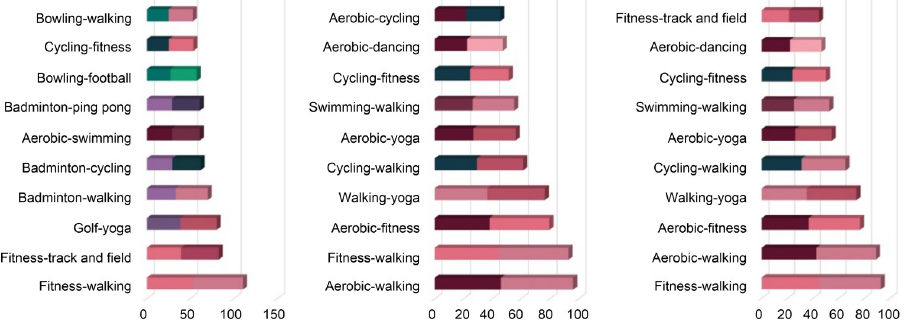
Fig 6. Survey (actual physical activity)—Top 10 (Korea, USA,